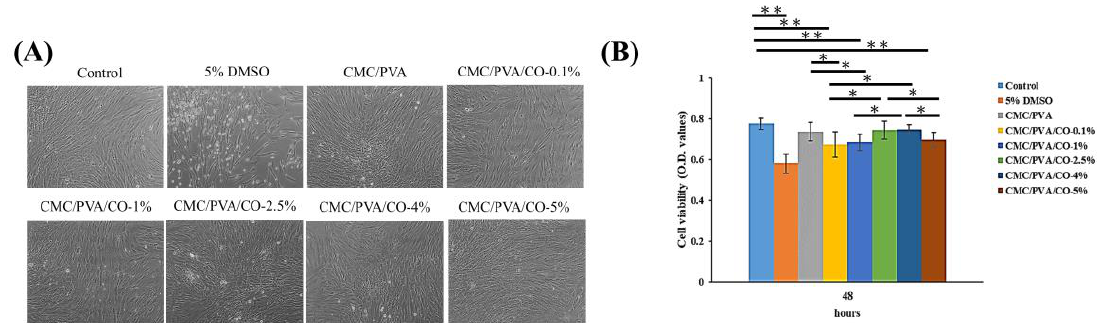
Figure 6. Biocompatibility evaluation of the CMC/PVA/CO composite films with different concen- trations of CO (0.0%, 0.1%, 1%, 2.5%, 4%, and 5%) using the MTT assay. ( A , B ) Average cell viability values among the control, 5% DMSO, and composite films. Results are expressed as mean ± standard deviation and statistical significance is represented as (*) p < 0.05 or (**) p < 0.01.